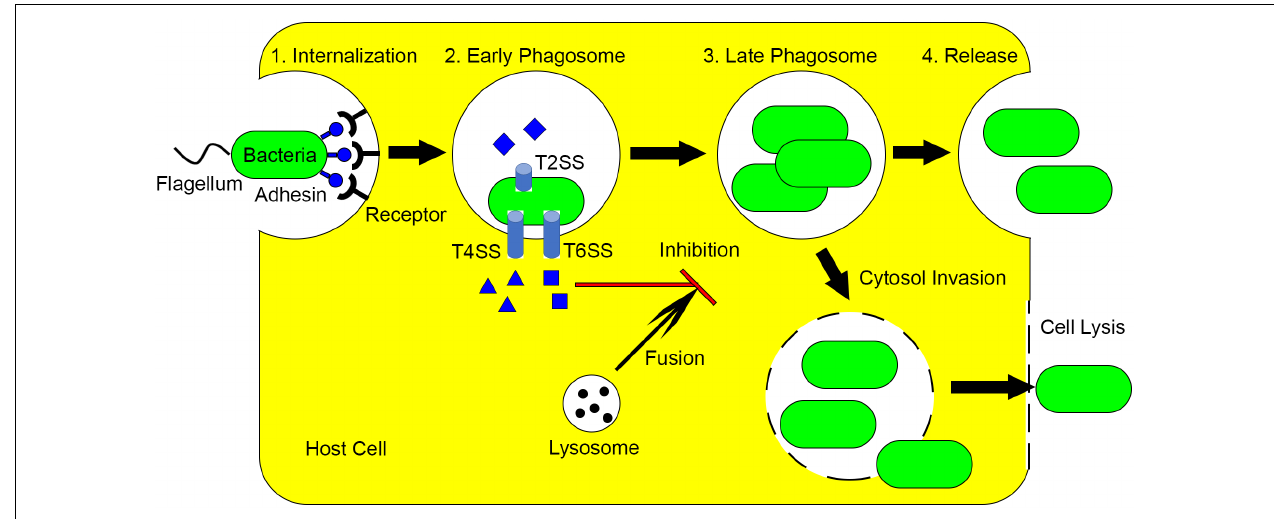
FIGURE 1 | Mechanisms utilized by intracellular pathogens to avoid killing by macrophage and protozoa. (1) Intracellular pathogens utilize flagella and adhesins to invade host cells. (2) After internalization, various effectors are produced through multiple secretion systems, which inhibits the lysosome phagosome fusion. (3) Depending on nutrient conditions, bacteria replicate in phagosome and/or enter cytosol. (4) The intracellular pathogens are released by exocytosis or lysis of host